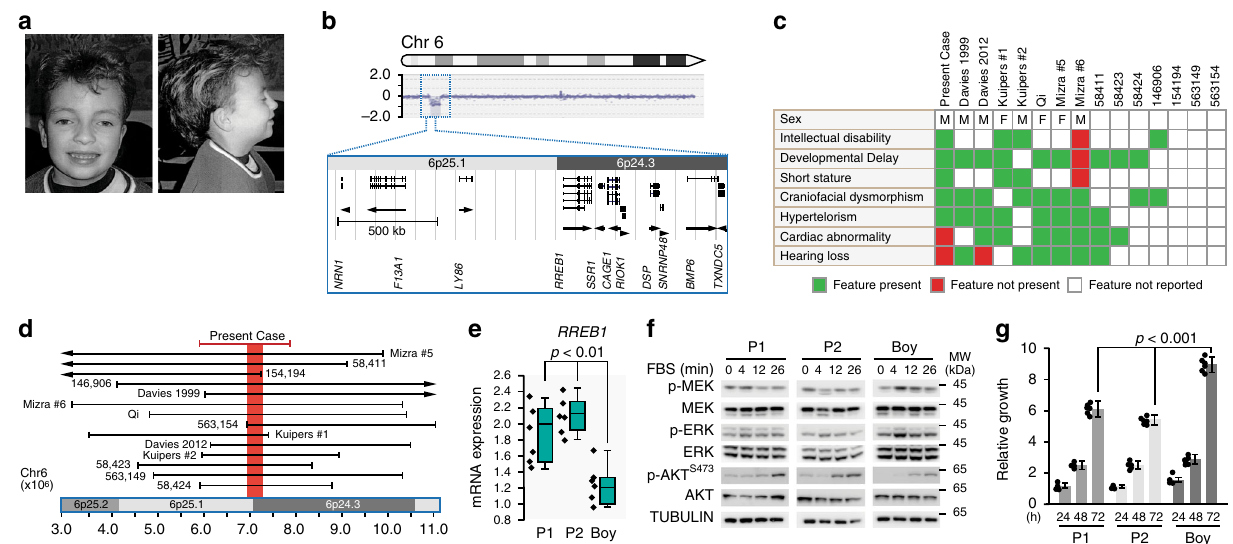
Fig. 1 RREB1 haploinsuf fi ciency causes a developmental syndrome. a Photograph of the proband described in the present study. b CGC array of the left arm of chromosome 6 identi fi ed a heterozygous 2.1 – 2.7MB microdeletion encompassing 6p25.1p24.3. Expanded region highlights the genes in the microdeletion (UCSC Genome Browser, hg18 assembly). Gene direct is indicated for each gene using an arrow head. c Clinical features associated with 6p interstitial deletion cases and d overlap of the reported deleted genomic regions involving 6p25.1 and 6p24.3. Case numbers refer to NCBI ClinVar entries. Red line represents the microdeletion in the proband of the present study. e mRNA expression of RREB1 in EBV transformed lymphoblastoid cells (LCLs) derived from the proband (Boy) and parents (P1, P2; n = 6). p = 0.007 (P1 vs. Boy), p = 0.0002 (P2 vs. Boy) two-tailed student ’ s t -test, box plots indicate the IQR of the data and the central line shows the median. f Western bot analysis of MAPK signaling in LCLs (P1, P2, Boy) following serum deprivation and stimulation with FBS for the indicated times. Experiment was initially a single membrane (provided in Supplementary Fig. 1), separated post exposure for clarity in the fi gure. Tubulin served as a loading control. Blots are representative of n = 6 experiments. g Relative growth (arbitrary units) of LCLs (P1, P2, Boy) in culture measured with Alomar Blue. Data average of n = 6 independent experiments, p = 3.4E-08 (P1 vs. Boy), p = 6.3E-10 (P2 vs. Boy) two-tailed student ’ s t -test, error bars presented as mean values± SD. Source data are provided as a Source Data fi